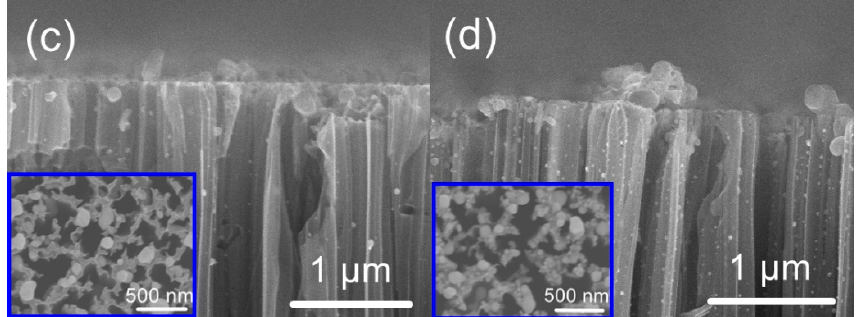
Figure 2. ( a ) SEM images of silicon nanowires covered with Ag particles at bottom of silicon nanowire array. ( b – d ) SEM images of silicon nanowire array coated with silver nanoparticles following UV irradiation for 2, 5, and 10 min, respectively. The concentration of Ag + in the solution was 2.5 mM.